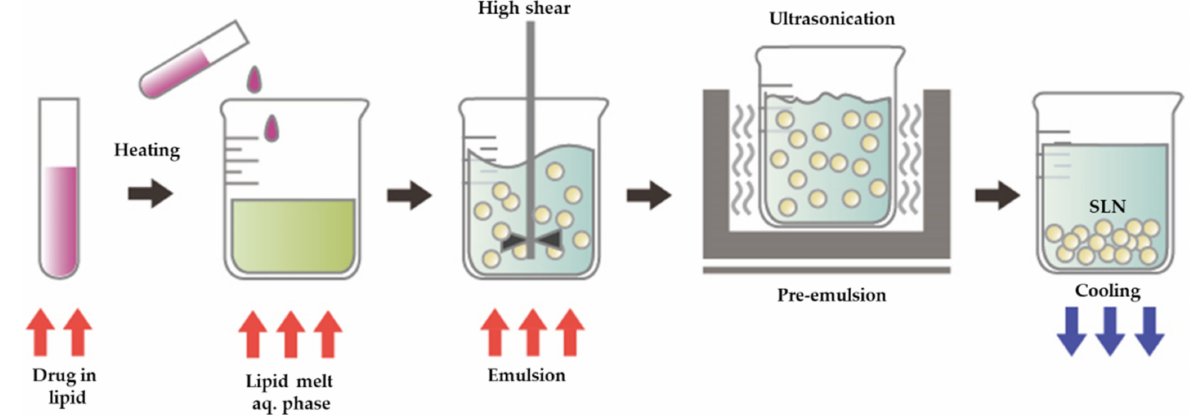
Figure 7. The procedure of high shear/high speed/ultrasonication homogenization.